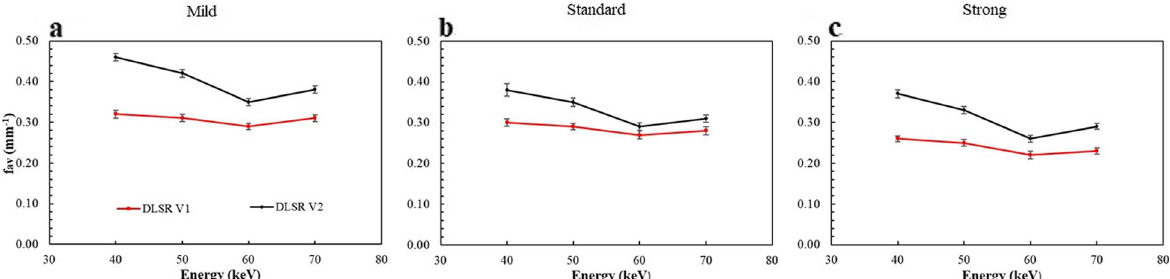
Fig. 3 Average noise spectrum frequencies (f av ) as for three levels of the deep learning spectral reconstruction (DLSR) versions (DLSR V1 and DLSR V2). a Mild level. b Standard level. c Strong level